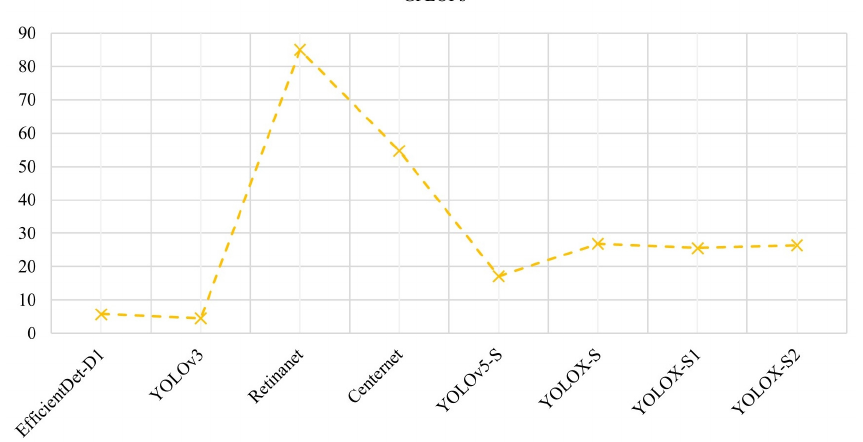
Figure 11. Computational complexity of the